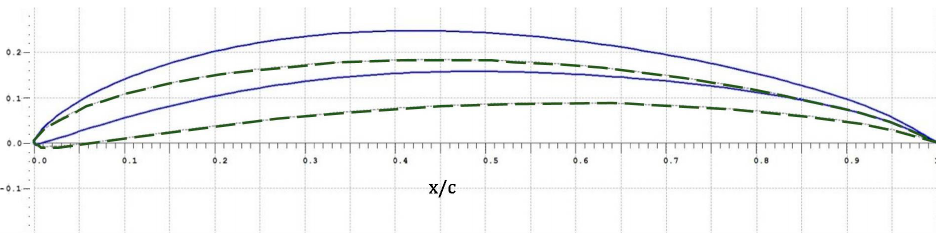
Figure 3. Eppler 61(dashed black line) vs. Mod 4 (continuous blue line) airfoils. Table 1. Geometry parameter of Eppler 61 profile and its modified version. In the table f stands for the curvature, t stands for the thickness and c stands for chord.